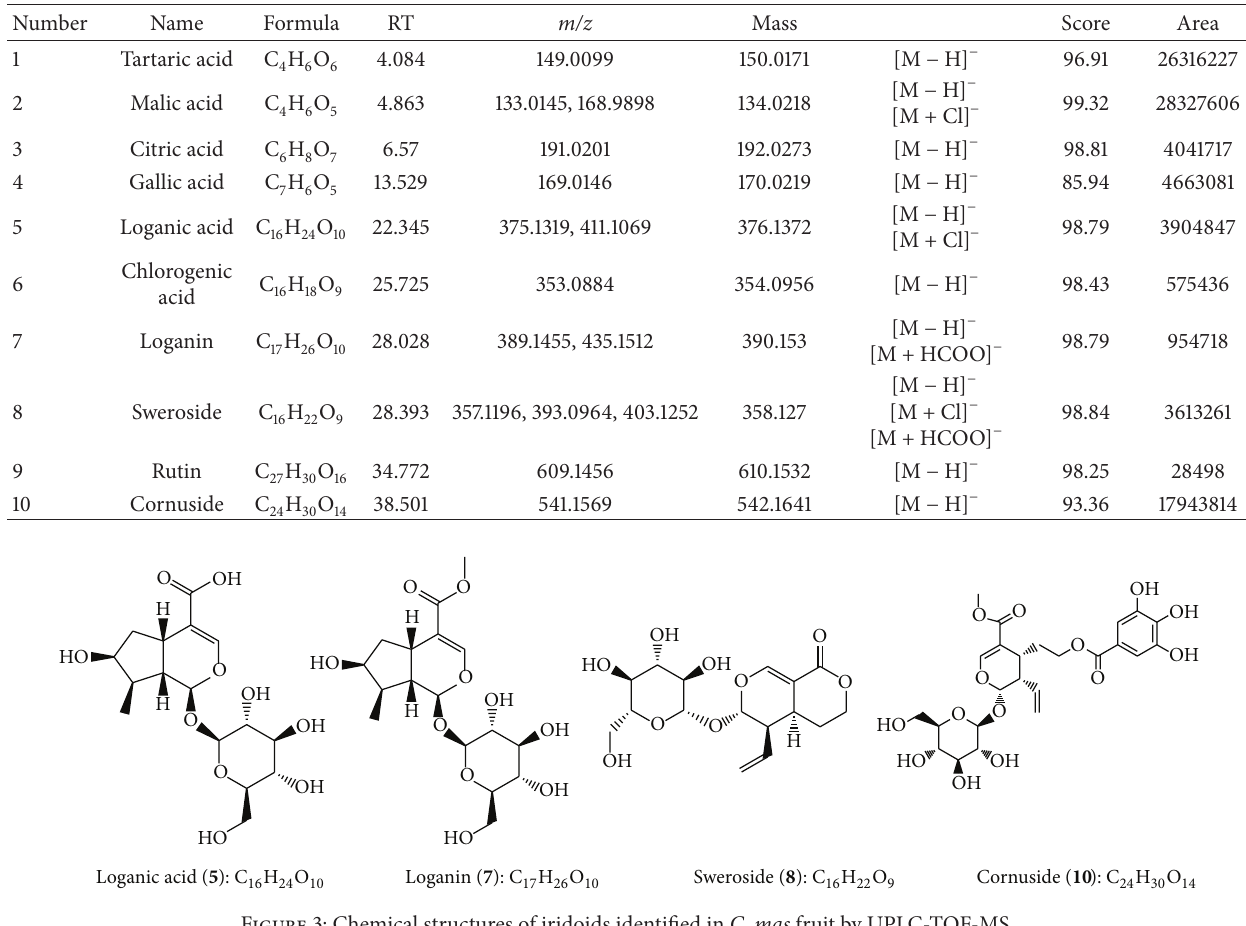
Table 1: Chromatographic and mass spectral data of phytochemical compounds identified in C. mas fruits.